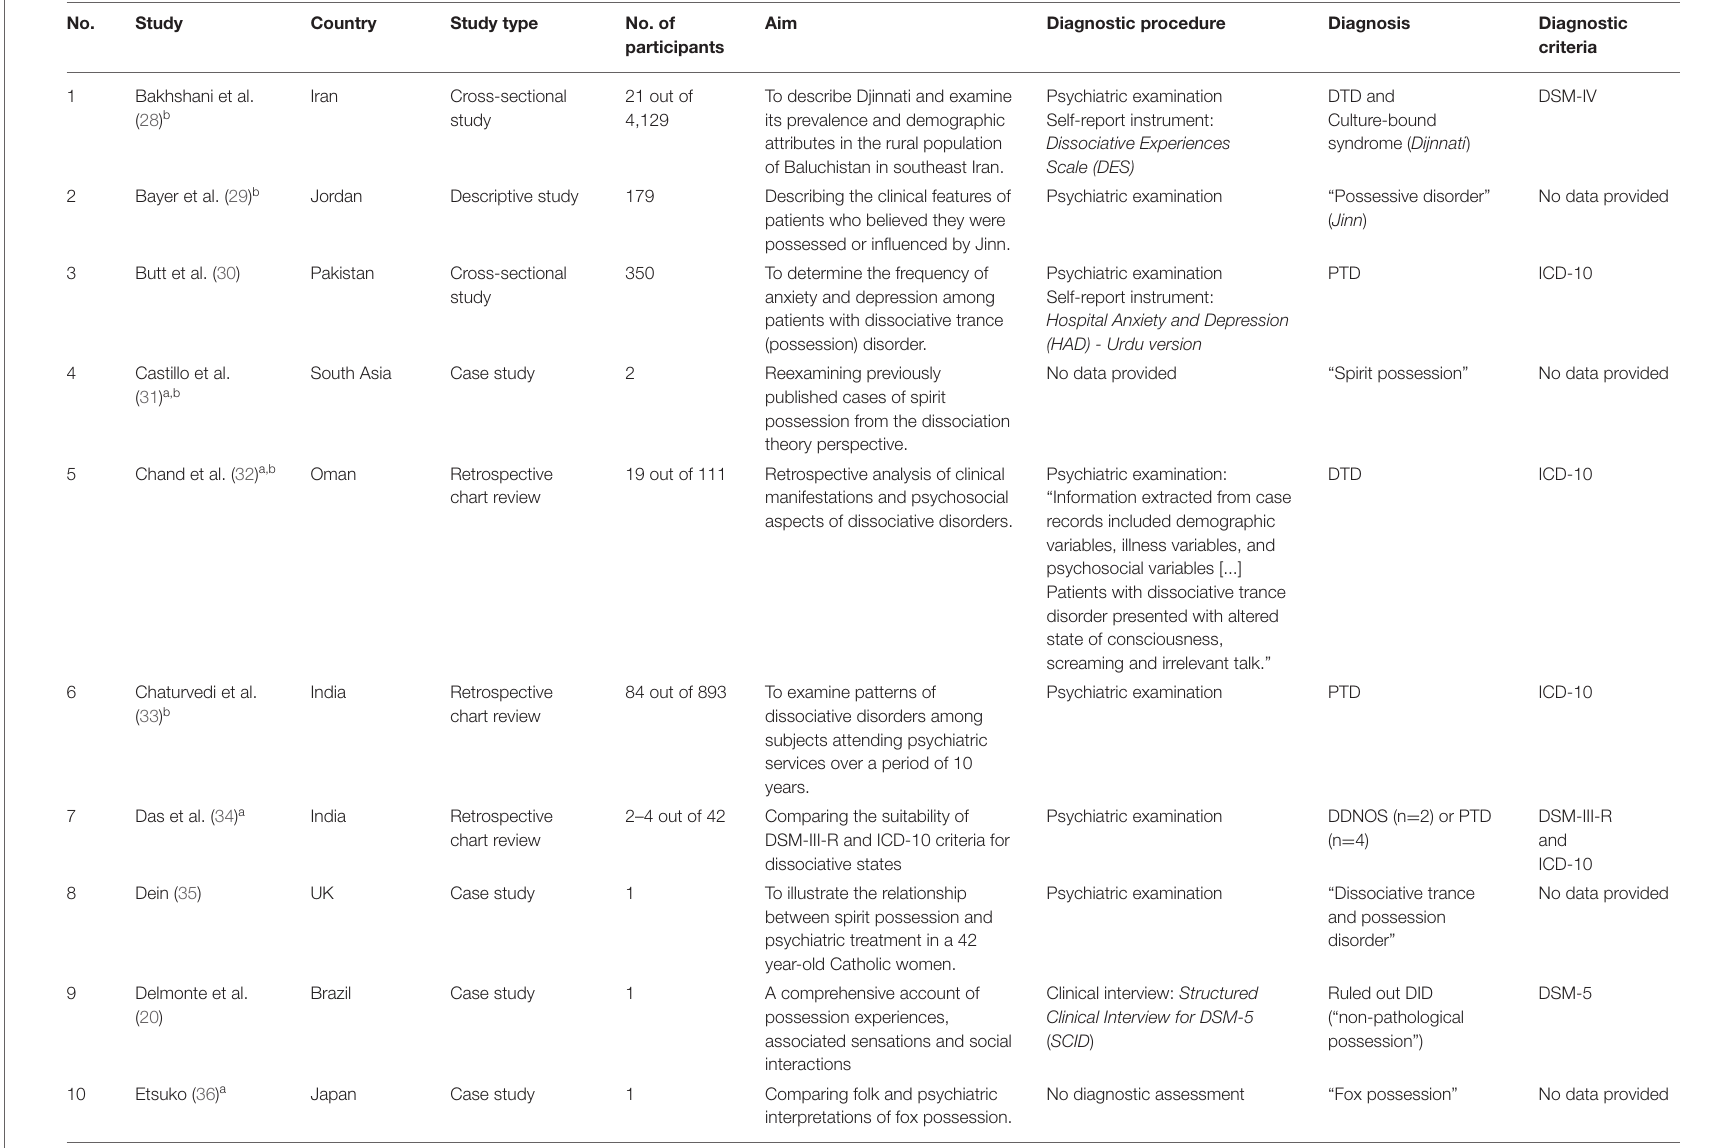
TABLE 2 | Review of studies exploring possession